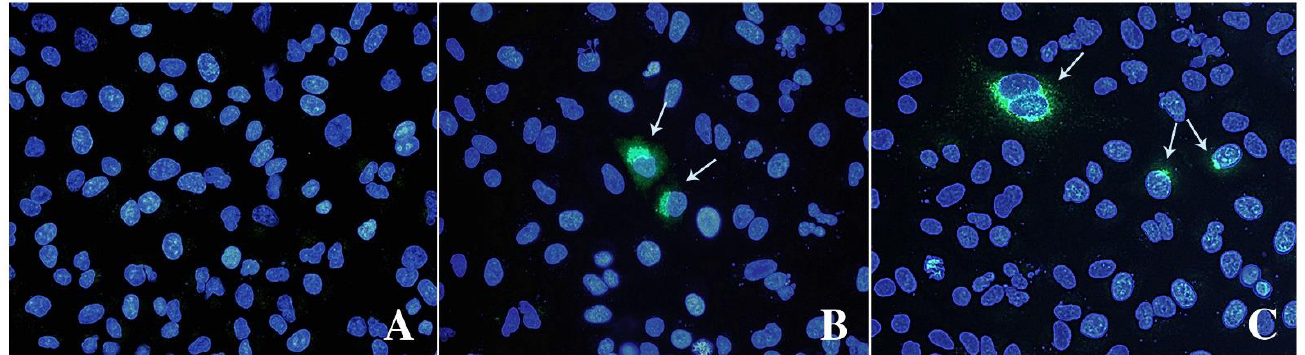
Figure 3. Immunofluorescence analysis of mock ( A ) and infected cells stained with anti-ORF-2 ( B ) and ORF-3 ( C ) primary antibodies. A goat anti-mouse IgG FITC antibody was used to bind primary antibodies. Cell nuclei were stained with DAPI (blue staining). Arrows indicate HEV- infected cells expressing viral proteins. Fluorescent images were taken using a Leica DM4000 fluorescence microscope. Viral stocks of the different subtypes recovered from cell supernatant at 9 weeks p.i. of the P2 passages were used to infect a new monolayer of A549, and a huge volume of viral stock was obtained during several weeks in the supernatant of cells adapted in growth medium without FBS, as described in Materials and Methods. The titre of the viral